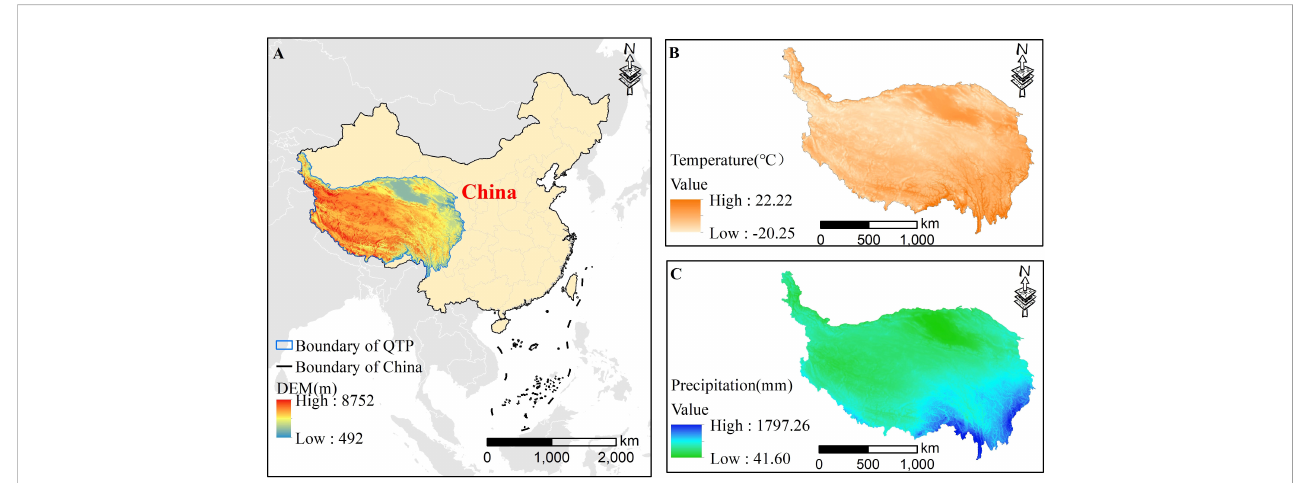
FIGURE 1 The location (A) , annual mean temperature (B) and annual mean precipitation (C) of the